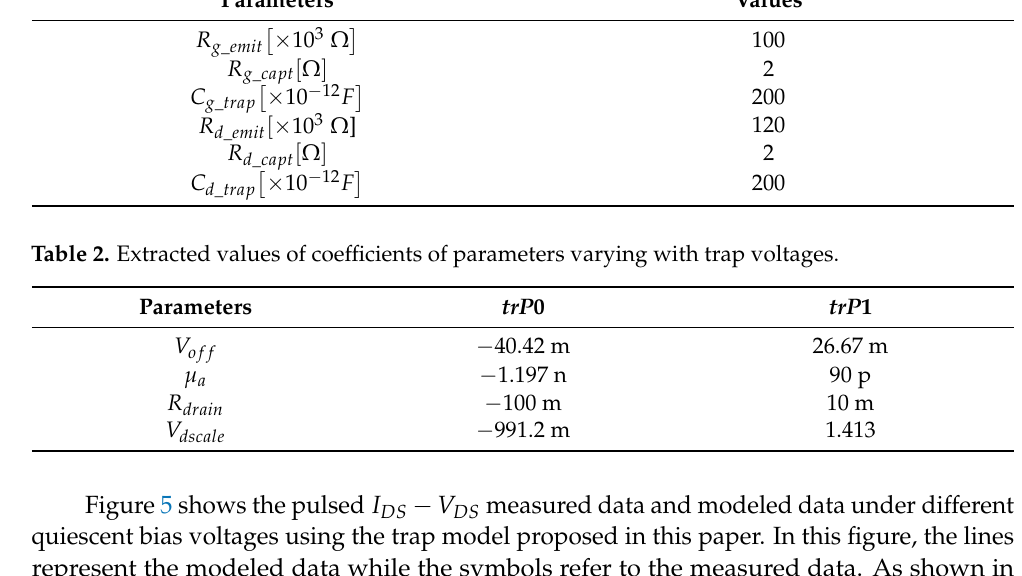
Table 1. Parameters of trap model.